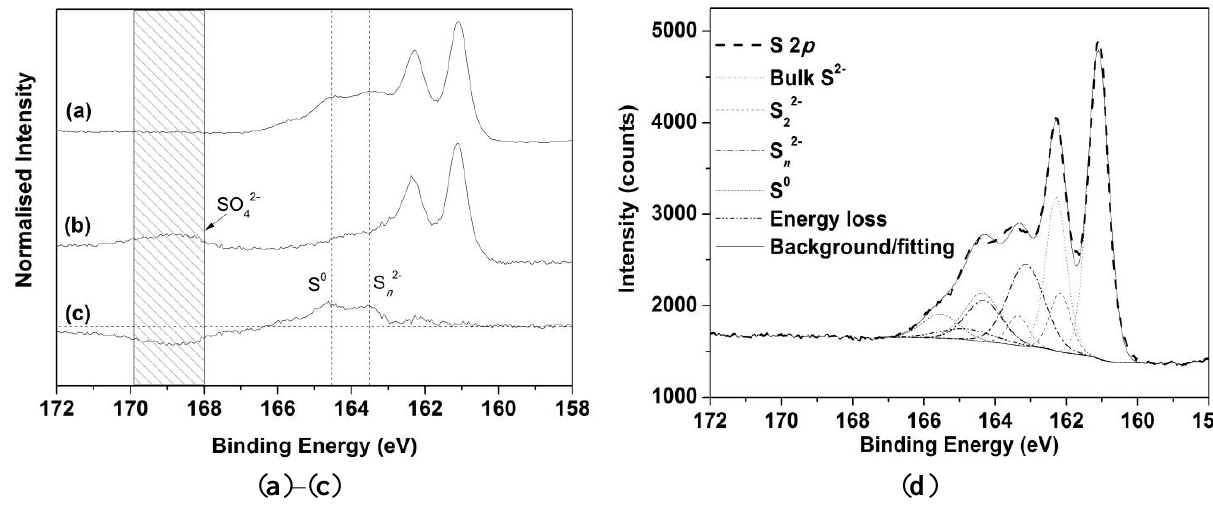
Figure 4. S 2p spectra collected from the chalcopyrite slabs dissolved at 750 mV, 75 °C and pH 1.0 for 30 h: ( a ) chalcopyrite from galvanic cell; ( b ) chalcopyrite only; ( c ) ( a ) minus ( b ); ( d ) fitting of ( a